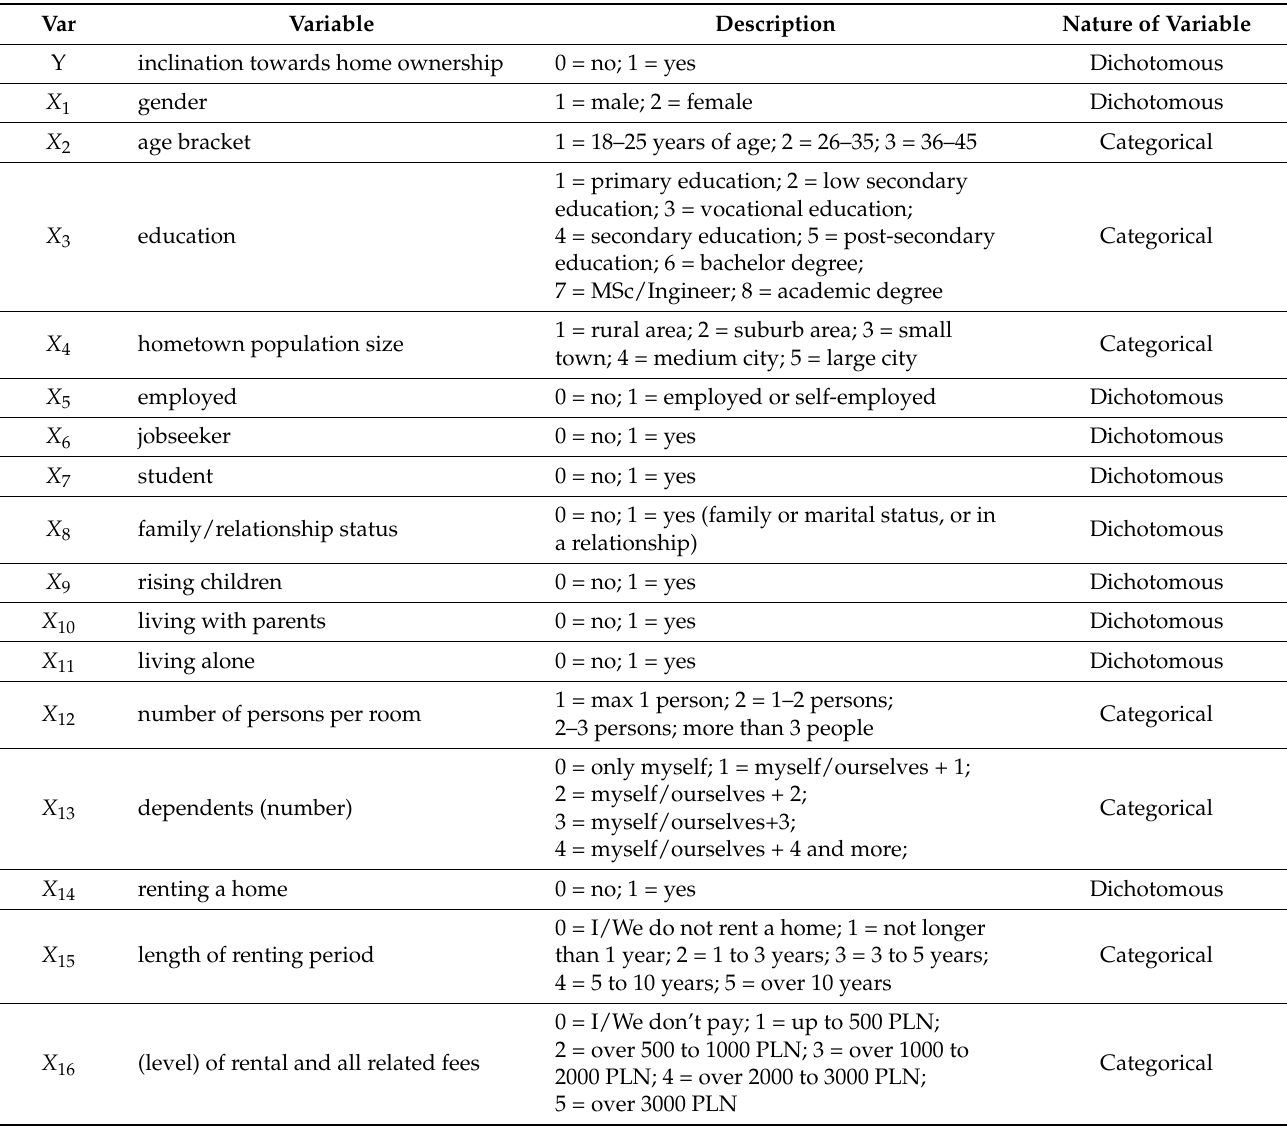
Table 1. List of variables included in the logistic regression